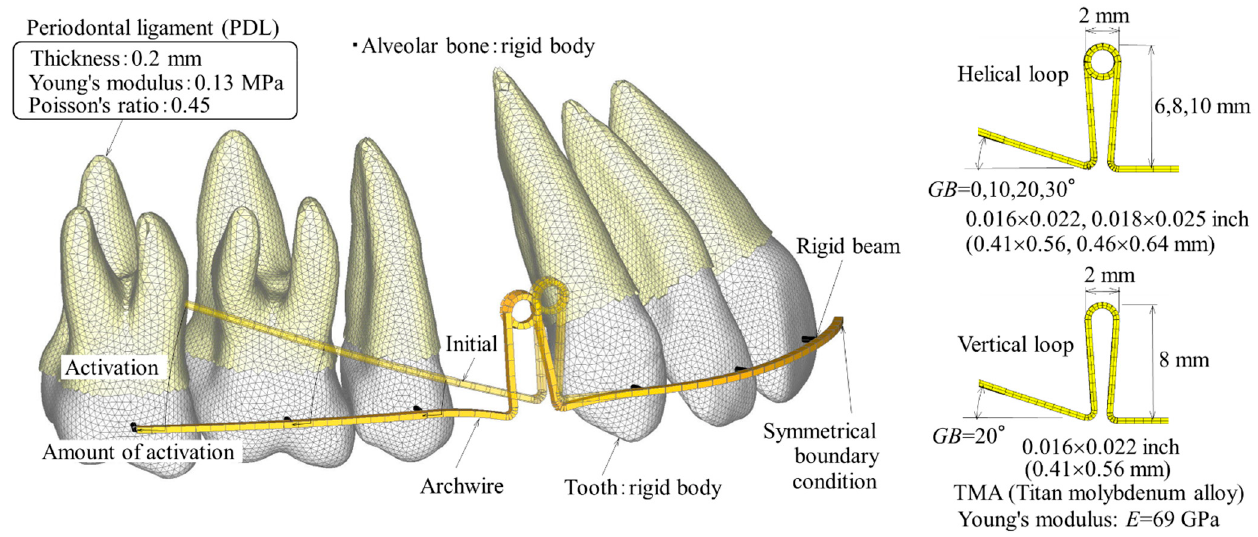
Figure 1. Finite element model for simulating extraction space closure using helical loop spring.